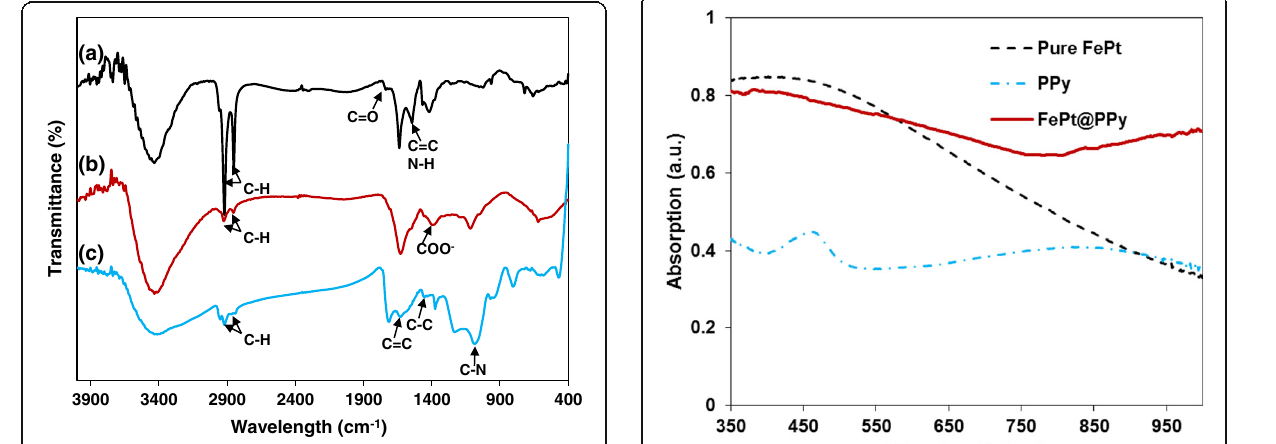
Fig. 2 FTIR spectra of (a) hydrophobic FePt NPs, (b) hydrophilic FePt NPs, and (c) FePt@PPy NPs Fig. 3 The UV-Vis-NIR spectra of pure FePt, PPy, and FePt@PPy